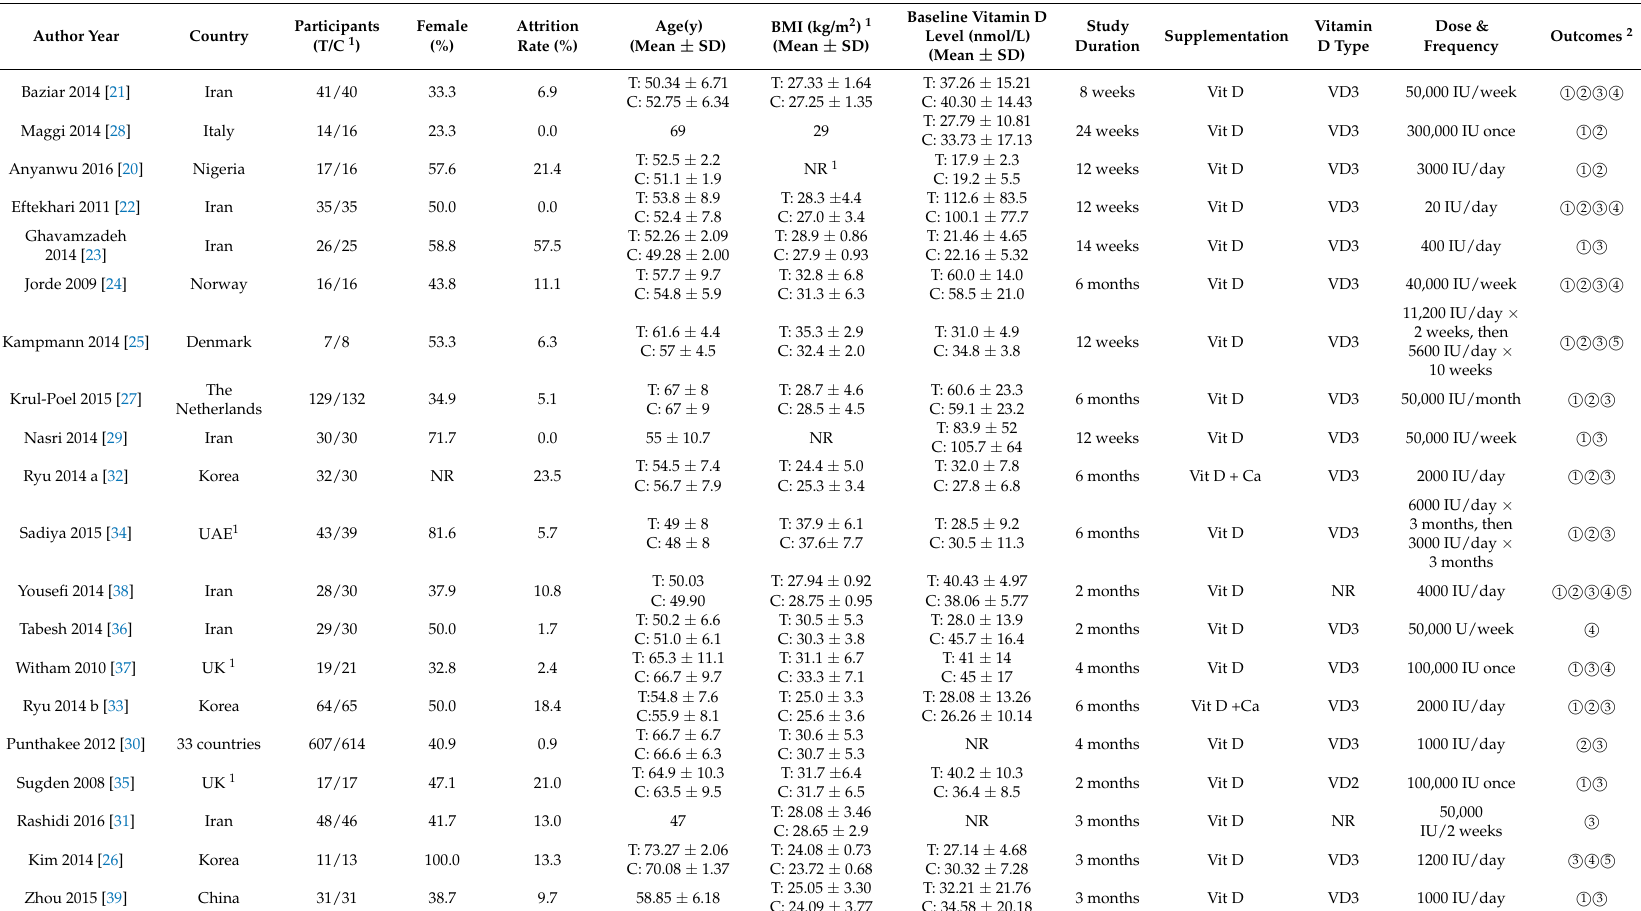
Table 1. Characteristics of studies included in the